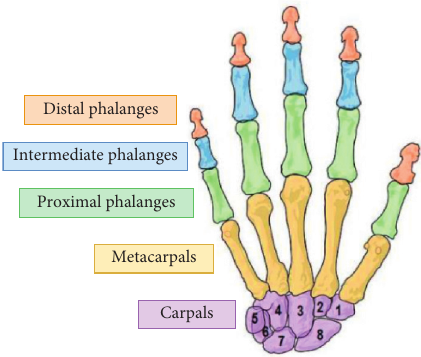
Figure 1: Anatomy of the human hand